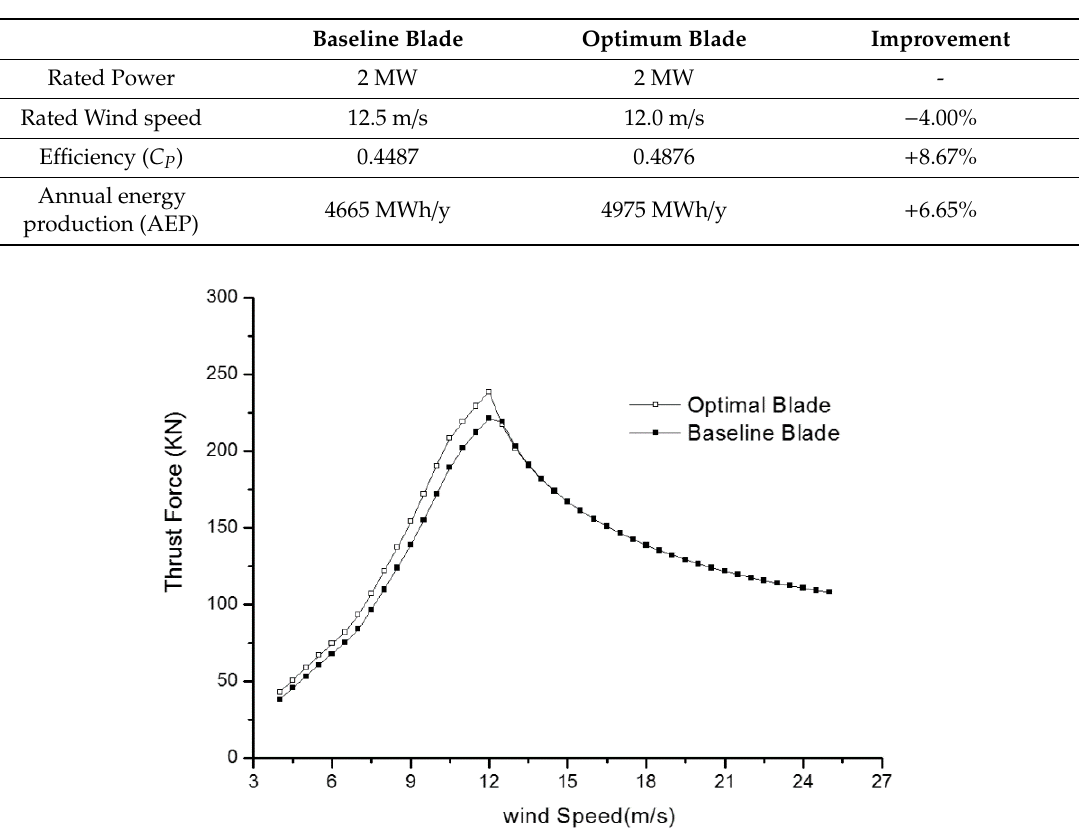
Figure 11. Thrust force comparison between the optimal and baseline blades.